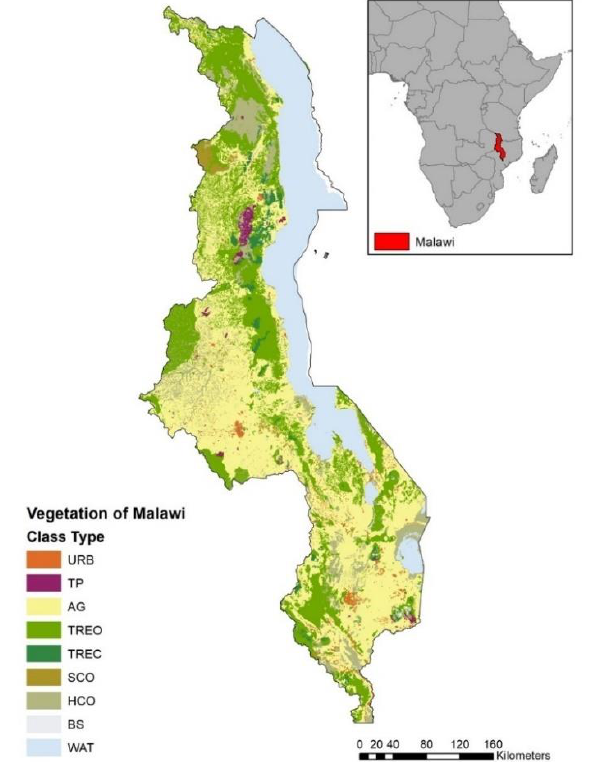
Figure 1. Vegetation of Malawi, showing the distribution of forests. The majority of forest is Miombo woodlands, both open and closed forests. This map was generated by the Food and Agriculture Organization of the United Nations (FAO. 2013. Atlas of Malawi Land Cover and Land Use Change, 1990–2010, Rome. 139 pp.) Codes are URB: Built Up, TP: Tree Plantation, AG: Agriculture, TREO: Tree Cover Open, TREC: Tree Cover Closed, SCO: Shrub Cover, HCO: Herbaceous Cover, BS: Bare Land, and WAT: Water Bodies.